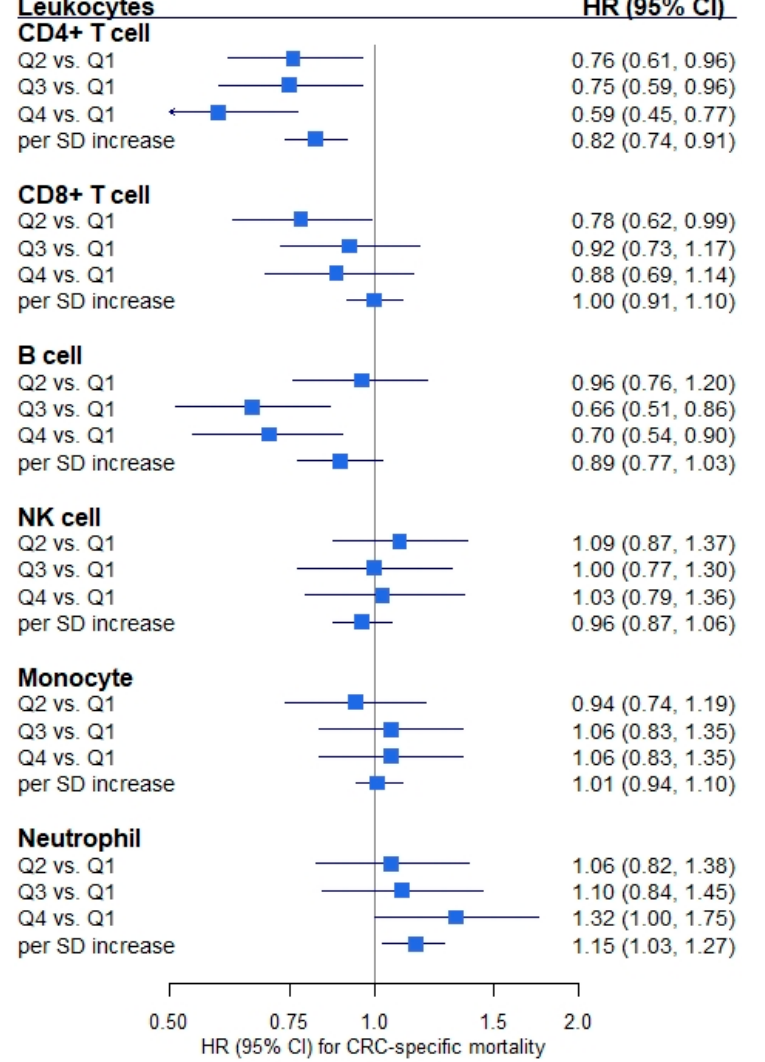
Figure 2. Forest plot of the associations between leukocyte composition and colorectal cancer (CRC)-specific mortality. Note: Hazard ratio (HR) and 95% confidence interval (CI) were derived from Cox regression model adjusting for age, sex, tumor stage, tumor subsite, timing of blood sampling and batch ( n patients = 2179, n deaths = 593). An HR of one means that there is no difference in survival between the two groups. Abbreviation: Q1–Q4, quartile 1 (lowest)–quartile 4 (highest); SD, standard